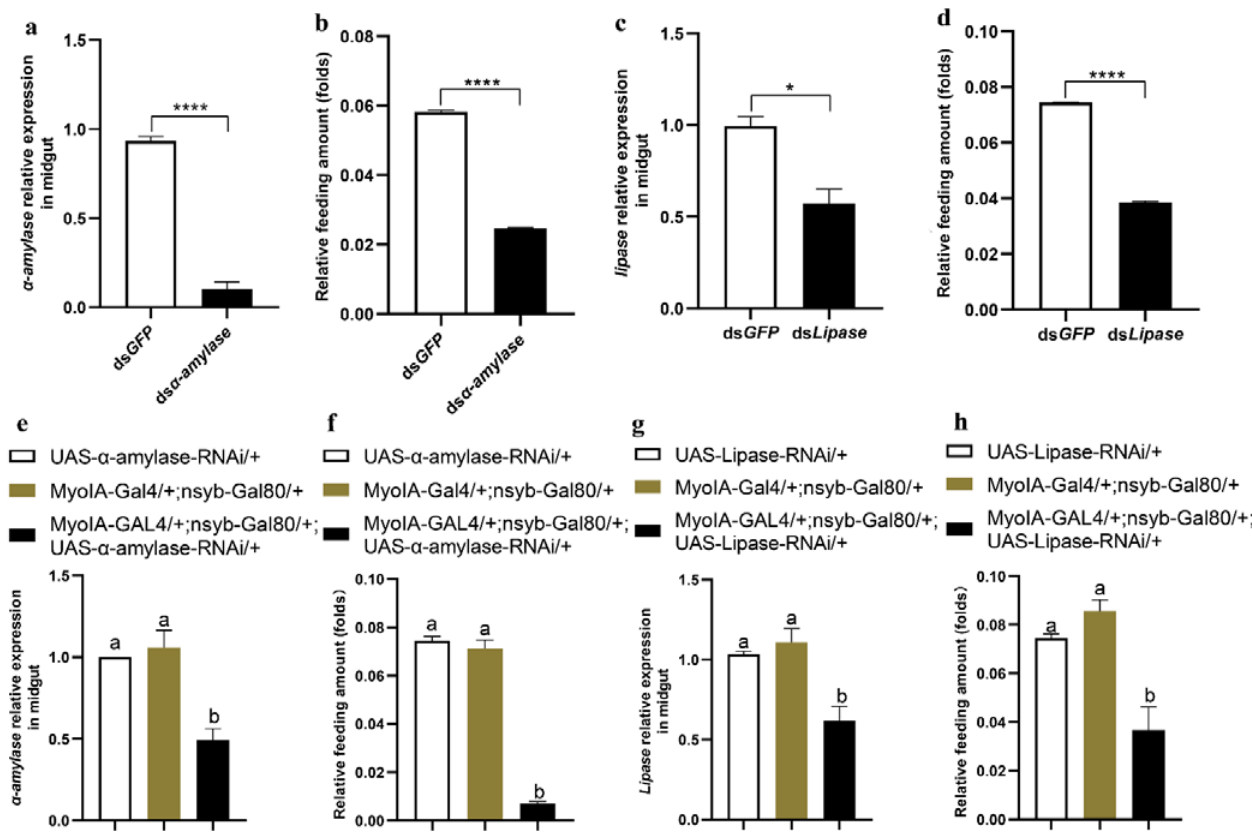
Figure 5. Effects of α -amylase and lipase on larval feeding. ( a , c ) Relative expression levels of α -amylase and lipase in the midgut after knockdown of α -amylase or lipase, respectively, for 3 h in 5th instar larvae of O. furnacalis . ( b , d ) Relative feeding amount of 5th instar larvae after knockdown of α -amylase or lipase for 3 h. ( e , g ) Relative expression levels of α -amylase and lipase at ZT2 in 3rd instar larvae of D. melanogaster . ( f , h ) Relative feeding amount of 3rd instar larvae at ZT2 of D. melanogaster . Bars represent the mean ± SE, * p < 0.05, **** p < 0.0001. Each treatment was repeated 3 times with 10 individuals per replicate. Different letters above the bars indicate significant differences at p < 0.05 as determined by Duncan’s multiple range test.